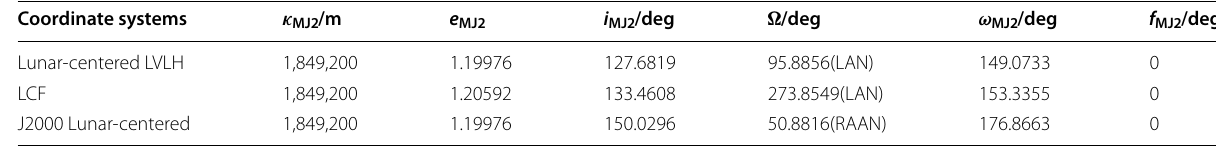
Table 2 The lunar‑centered modified classical orbital elements by the retrograde semi‑analytical model at LOI epoch Coordinate systems